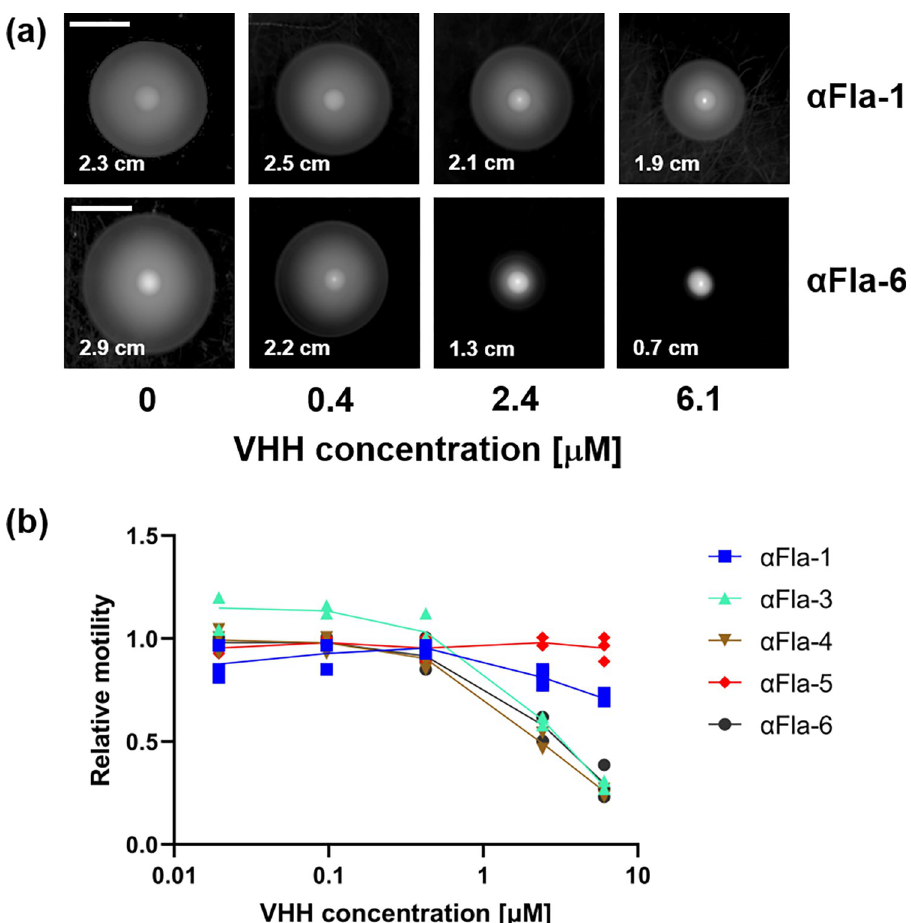
Fig 2. Anti-Fla VHHs can inhibit REPEC motility. (a) Representative images of REPEC growth on motility plates after incubation with varying VHH concentrations with spread diameter indicated (scale bar = 1 cm). (b) Relative motility as a function of α Fla VHH concentration. Spread diameters were normalized to a “no VHH” control.